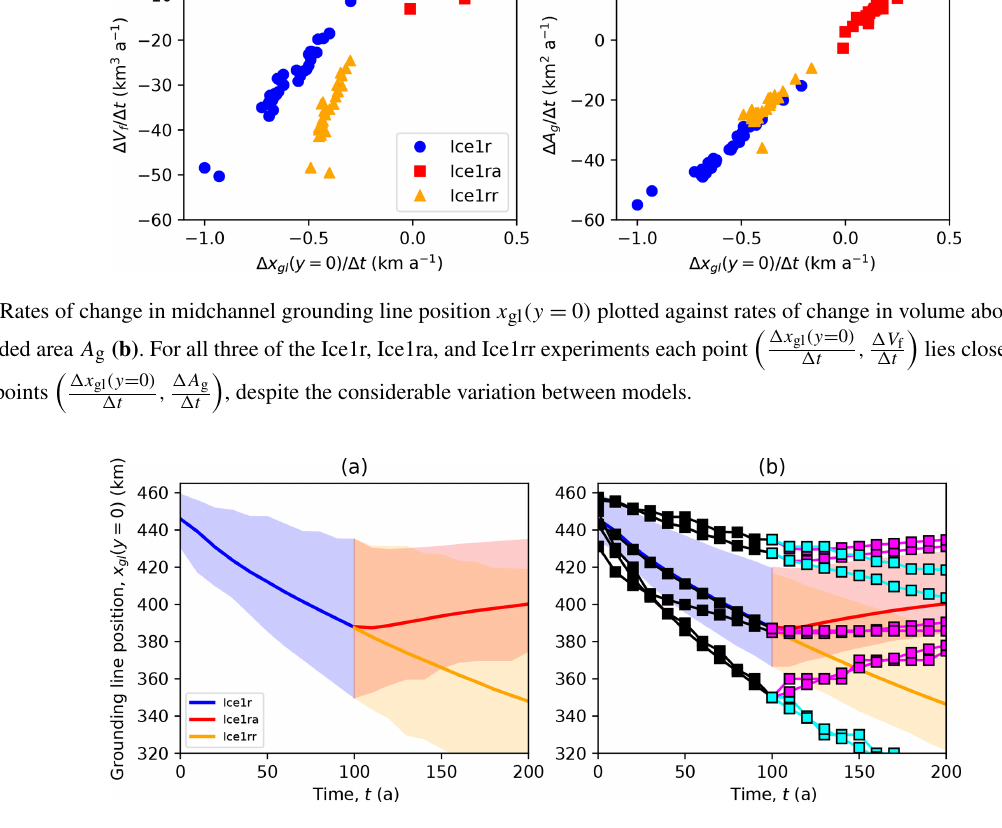
Figure 6. Midchannel grounding line position plotted against time for the Ice1 experiments. Panel (a) shows the mean (solid curves) and the range (shaded regions) over all models. Panel (b) shows the mean (solid curves) and range (shaded regions) for the main subset, with individual curves (lines and symbols) for the